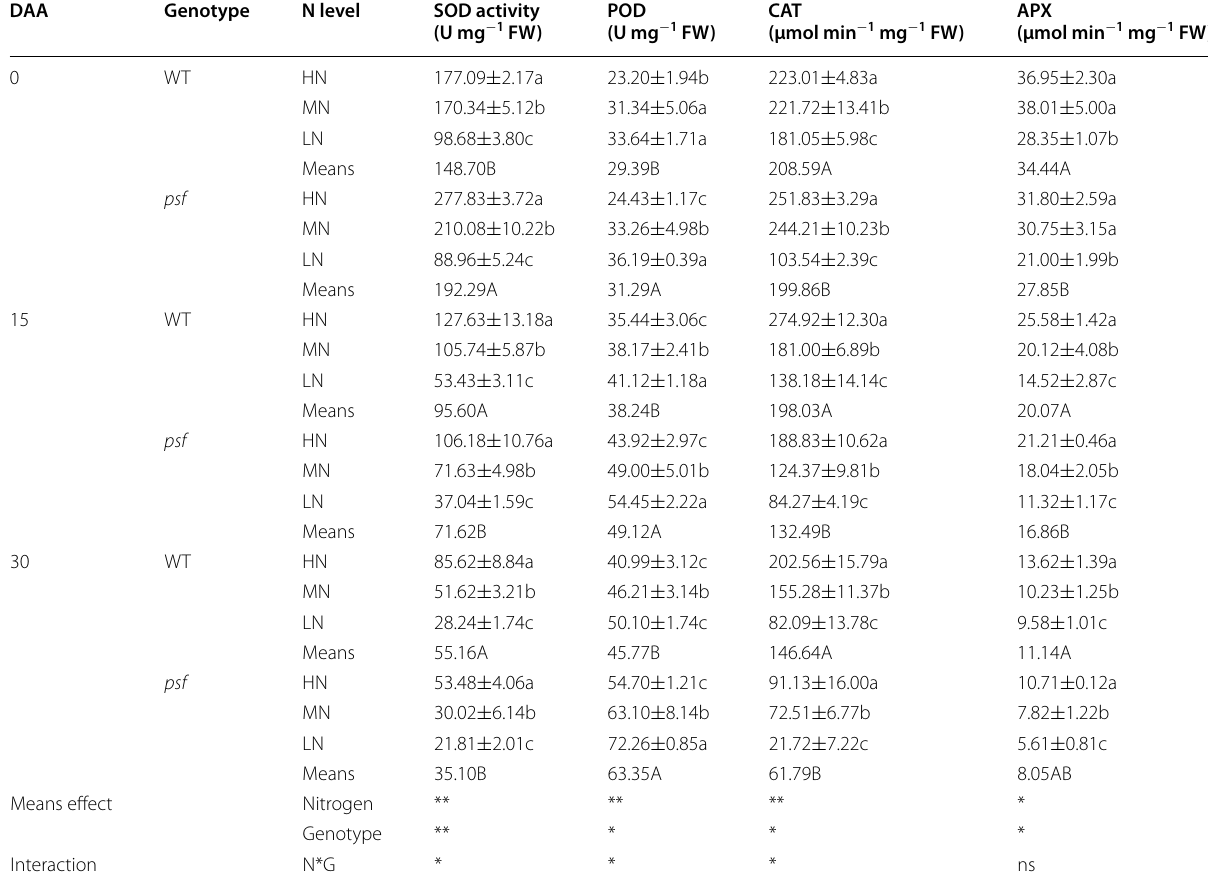
Table 3 Difference in antioxidants enzyme activities in the flag leaves of psf mutant and its wildtype under different nitrogen supplies during grain